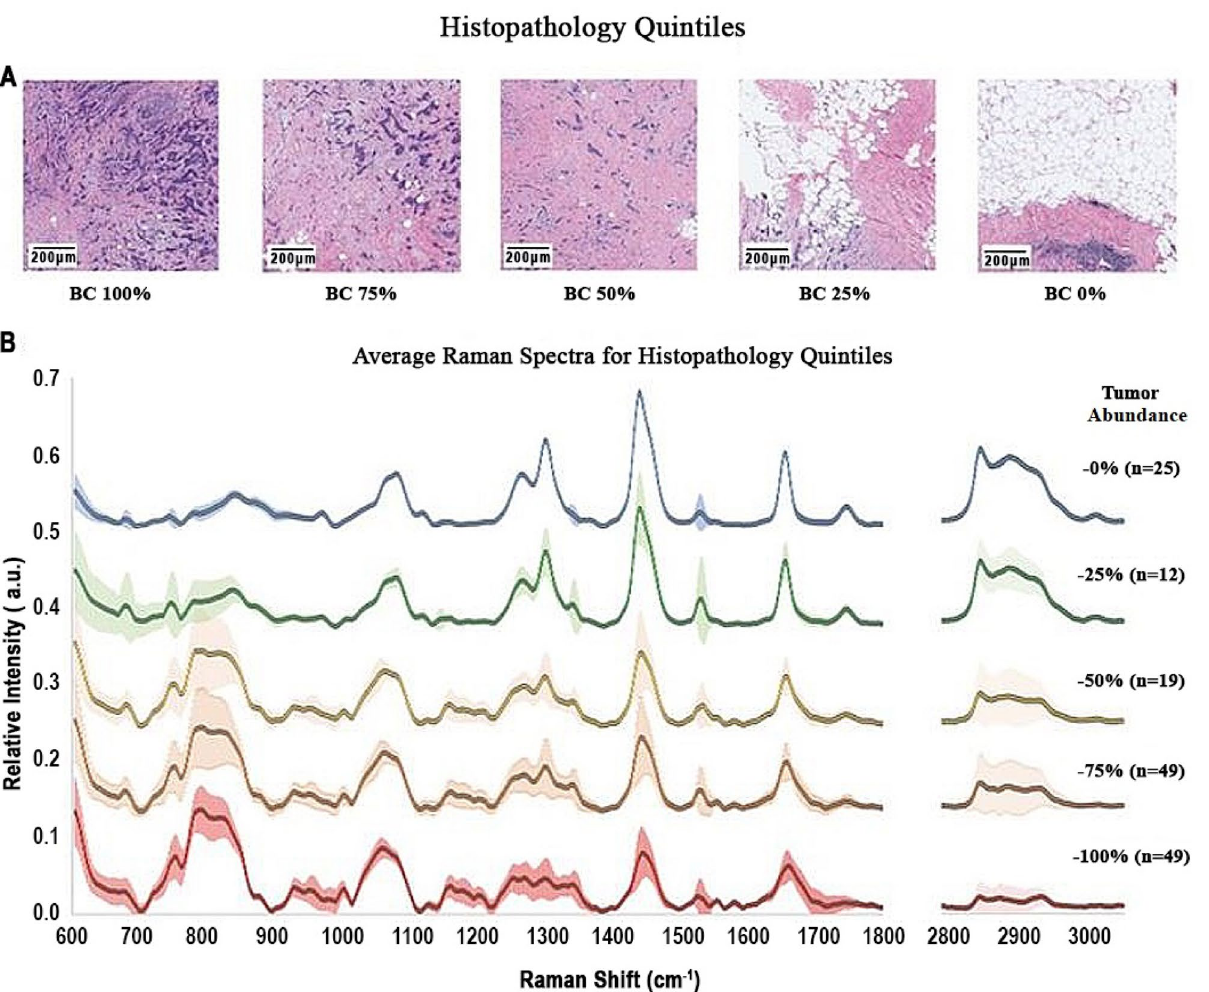
Figure 1. Breast cancer histopathology and corresponding laser Raman spectra (n = 154, 5 patients). Quintile estimate were made by the clinical pathologist (DS) for 1 mm 2 areas surrounding the projected location of the Raman laser probe. ( A ) Shows the H&E stains for examples of the five tissue categories. Mean LRS spectrum for each of the five categories (n0 = 25; n25 = 12; n50 = 19; n75 = 49; n100 = 49) appear in ( B ). If a region is assigned to the 100% quintile it means that tumor cells are apparent in all portions of the image. If a region is assigned to the 0% quintile it means that there were no clusters of tumor cells apparent throughout the image. Quintile assignment was accomplished for 154 images and spectra acquired from five (5) patients. Average spectra are displayed along with 1-sigma error bars. Scale bars are 200